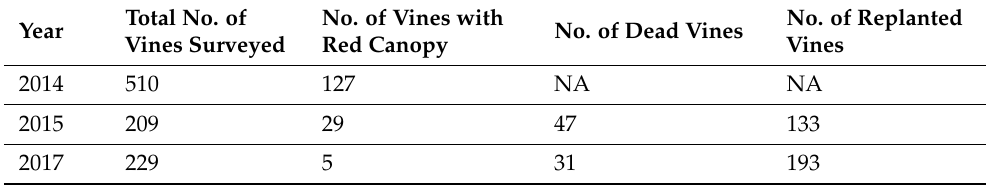
Figure 1. Symptoms of Syrah decline observed in a commercial Syrah vineyard in Niagara, Ontario, Canada. ( A ) An infected vineyard block with Syrah decline. Arrows indicate the vines with a red canopy. ( B ) A vine without a red canopy. ( C ) A vine with a red canopy. ( D ) The graft union of a vine without a red canopy. ( E ) The graft union of a vine with a red canopy. Typical symptoms of Syrah decline include a red canopy ( C ), swelling and crevasses at the graft union ( E ). Table 2. Syrah decline frequency in Ontarian vineyards. The survey was conducted in the month of September in 2014, 2015 and 2017 in vineyard block 2, where Syrah clone 100 grafted on the rootstock 3309C was planted. NA: not available. Total No.